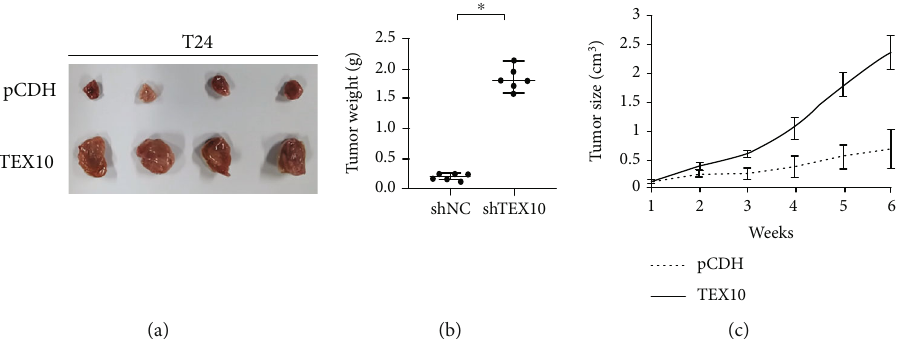
Figure 3: TEX10 accelerates urinary bladder carcinoma growth in vivo. T24 cells with the steady expression of pCDH and TEX10 received the injection to fl ank area of female BALB/c nude rats aged for 6 weeks ( n = 6 ). After 6 weeks of injection, xenograft tumors received the harvesting. Images regarding harvested tumors (a), tumor weight (b), and tumor growth curves (c) are presented. Shown is the mean ± SEM . ∗ P < 0 : 05 ; ∗∗ < 0.01; ∗∗∗ < 0.001, Student ’ s t -test.